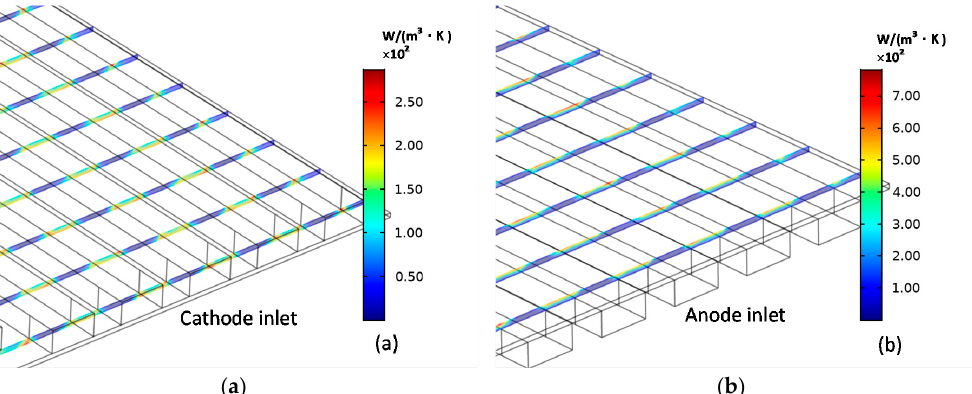
Figure 6. Cathode ( a ) entropy production and anode ( b ) entropy production caused by ohmic loss.